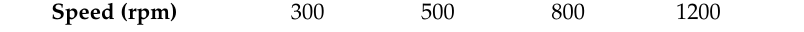
Figure 15. Comparative results of the phase current, the integral of the line voltage difference, and their enlarged view at a speed of 800 rpm and load torque of 12 Nm. Table 5. Convergence rate of proposed strategy.